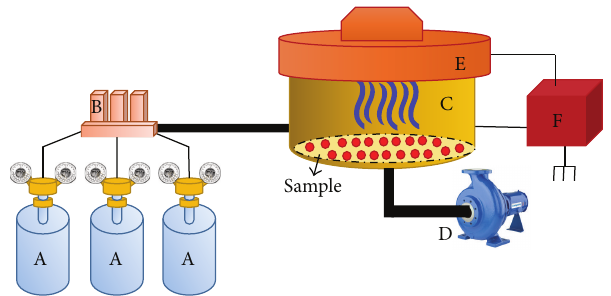
Figure 4: Diagram of the low-pressure vacuum MF plasma appa- ratus. The selected gases from the gas cylinders (A), connected to a mass flow controller (B), are controlling defined amount of gases to low-pressure vacuum plasma chamber (C) which is bound up with a vacuum pump (D). Defined work atmosphere is energized by MW (microwave) plasma head (E) which is powered by MW generator